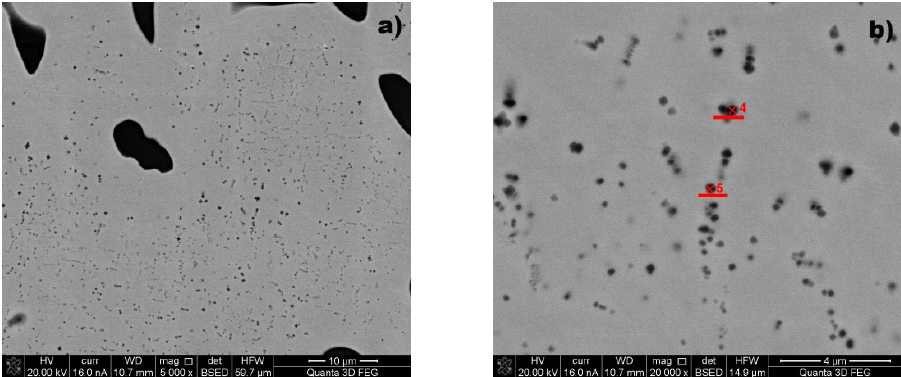
Figure 8. ( a ) examples of secondary carbides visible in an alloy containing 6.3% V. ( b ) red marks denote places of analysis for the alloy containing 8.1% V. Table 4. Sample chemical compositions of the visible precipitates (Figure